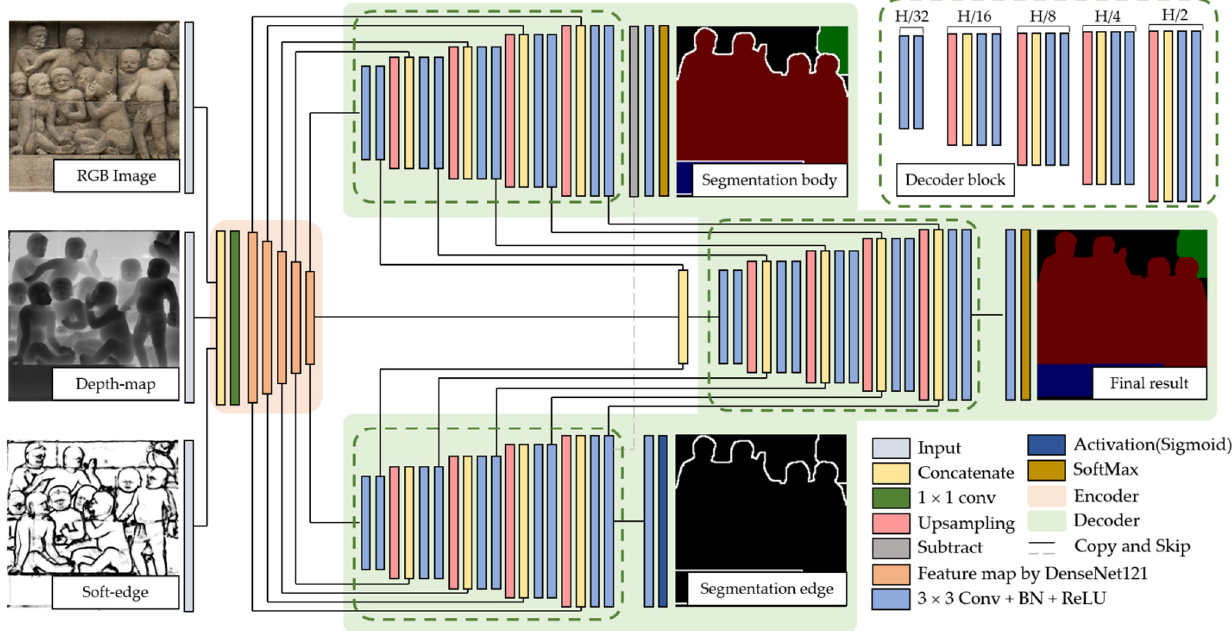
Figure 7. Structure of the soft-edge enhanced network. This is a multichannel input network with RGB images, depth maps, and soft-edge images. The network utilizes DenseNet121 as the backbone and extracts five sizes of feature layers: H/2, H/4, H/8, H/16, and H/32. Three decoder blocks (as shown in the upper right) are set to supervise the segmentation edge and segmentation body intermediate layer and semantic segmentation results in the decoder sections.